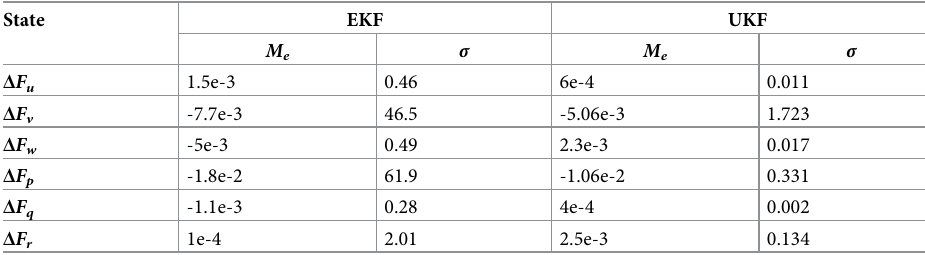
Table 4. Case 2: Mean estimation error for all